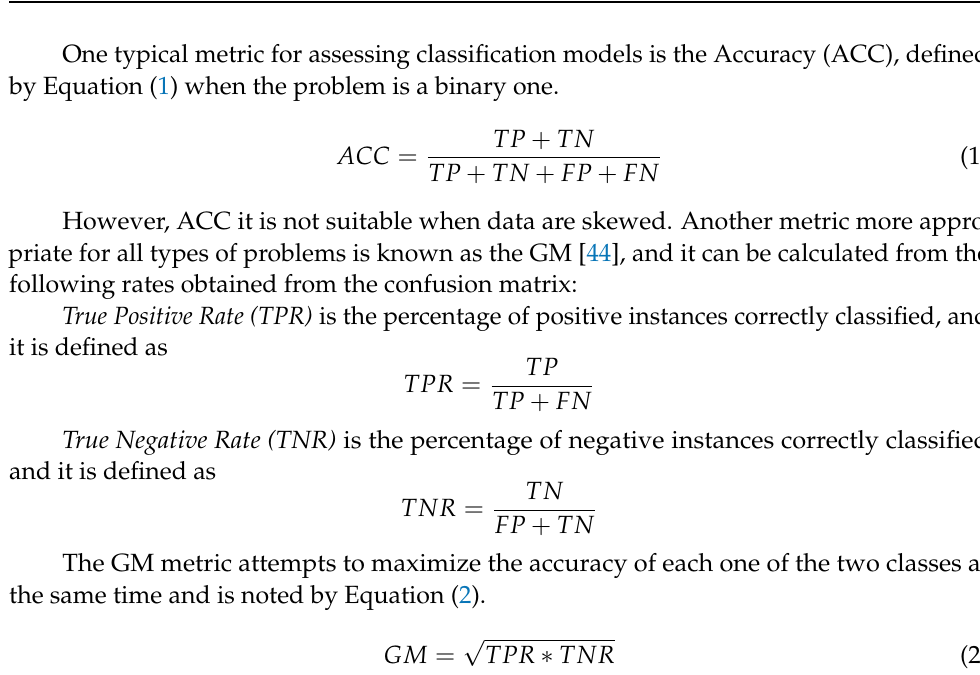
Table 4. Confusion matrix for performance evaluation of a binary classification problem. Predicted Actual Positive Negative Positive True positive (TP) False negative (FN) Negative False positive (FP) True negative